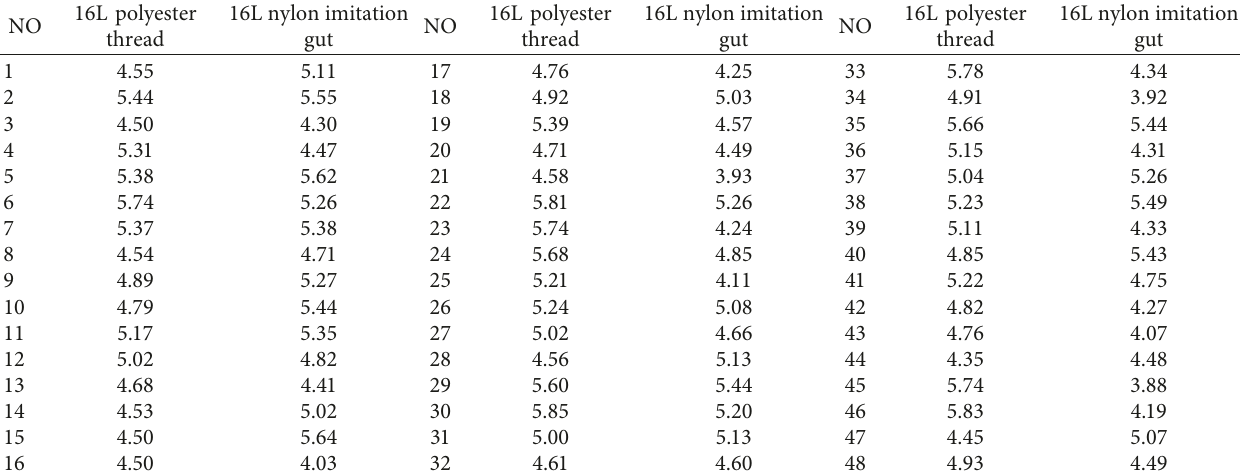
Table 2: The control score of different material